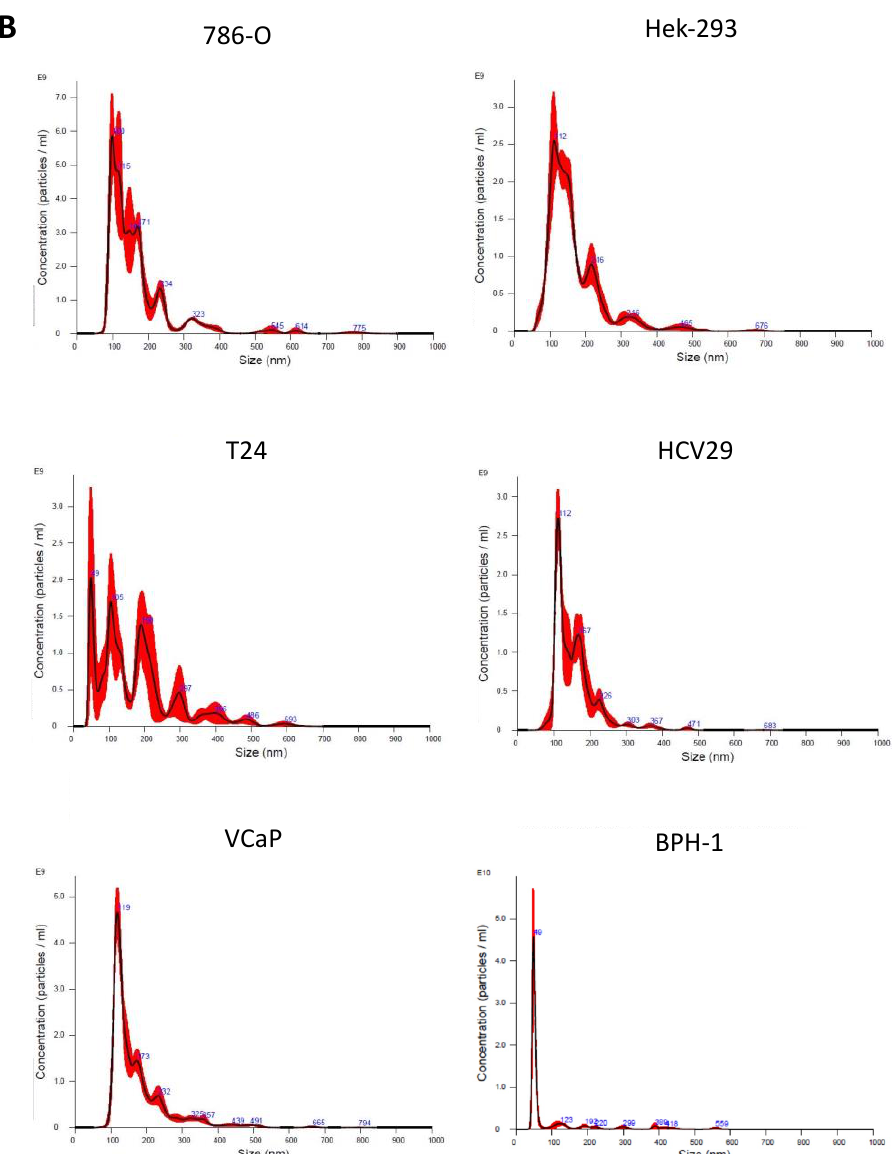
Figure 2. Western Blot ( A ) and Nanoparticle Tracking ( B ) analyses of all included cell lines and their extracellular vesicles. Whole-cell lysates are shown in lane 1 to 6, lysates from EVs are shown in lanes 7 to 12. Each lane was loaded with 20 µ g of total protein. GM130 served as cellular contamination markers, Alix, CD9, CD63, CD81, and Syntenin as EV markers, GAPDH and β Actin as loading controls. B Size distribution of EVs from 786-O, Hek-293, T24, HCV29, VCaP, and BPH-1 cells as determined by Nanoparticle tracking analysis. The mean (black line) +/ − 1 standard error of the mean (red areas) are shown. The original blots can be found at Figure S22.